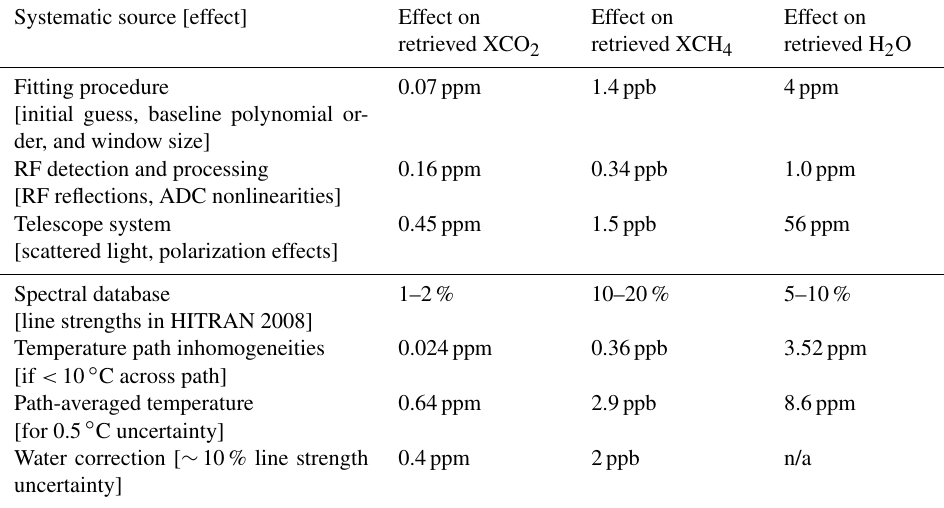
Table 2. List of systematic uncertainties. See discussion in Sect. 3.2 and 3.4 for more details. Upper half of table: instrument-specific systematics. Lower half of the table: model-dependent systematics common to both instruments. The final row is the estimated added uncertainty from the water correction, which is dominated by the nominal ∼ 10% line strength uncertainty of the spectral database. (The fit uncertainty for the retrieved water concentration is much lower at